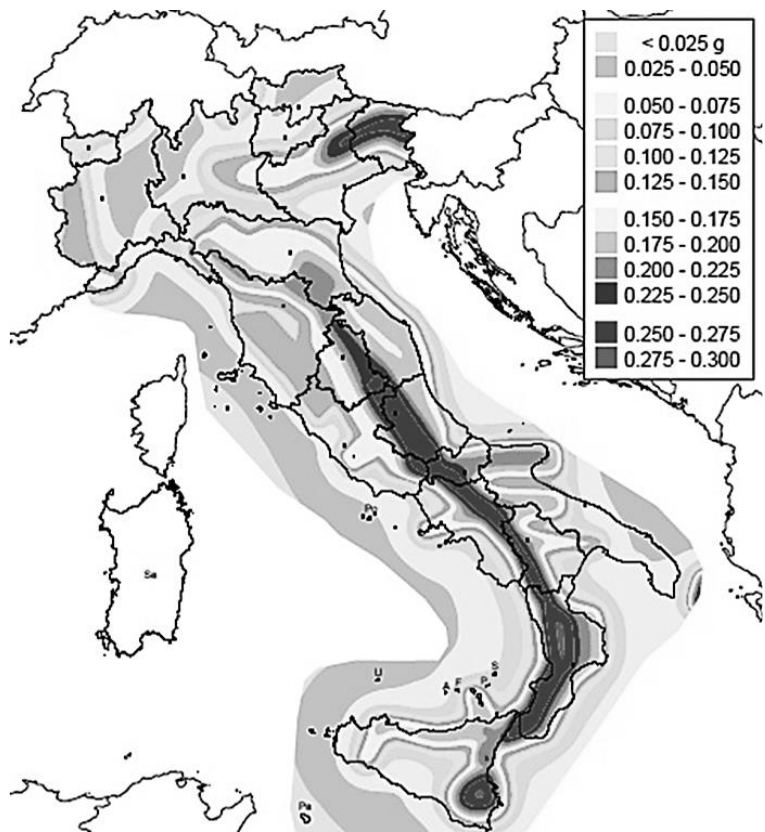
Figure 2. Map of seismic dangerousness along the national